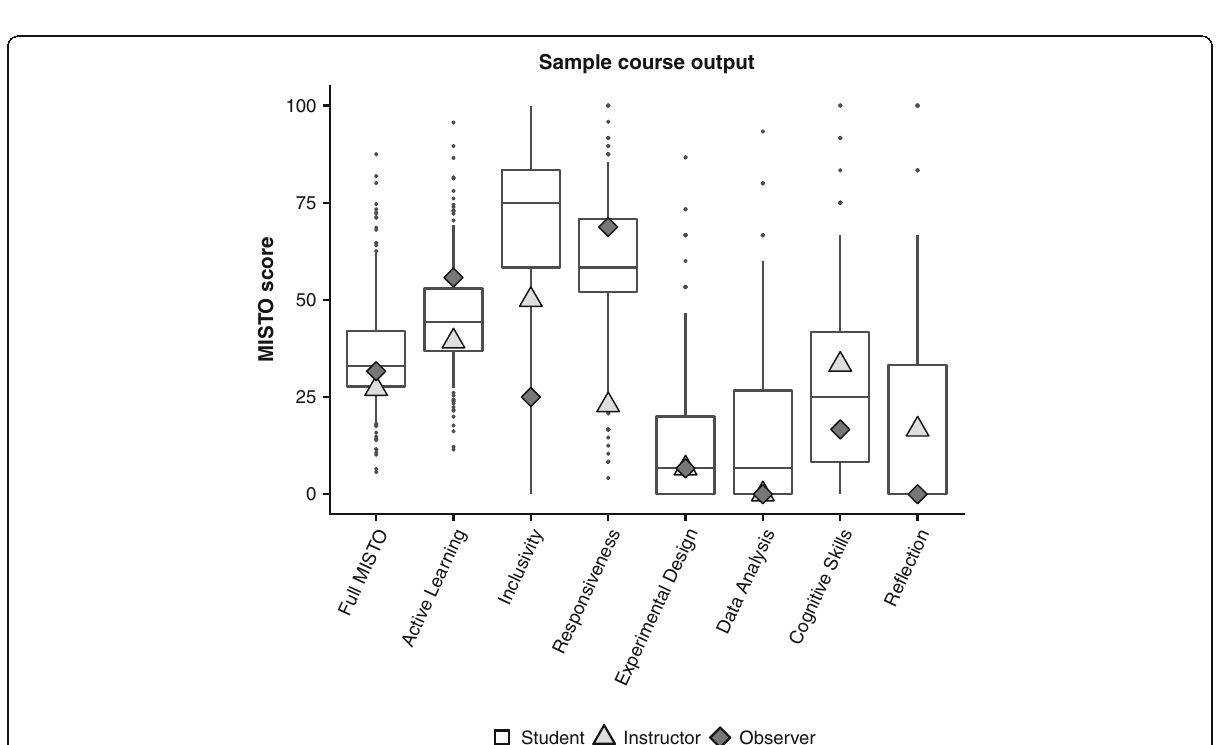
Fig. 6 Sample MISTO course output. Example output of student, instructor, and observer MISTO scores for an example course. Light gray triangles represent the instructor scores, and the dark gray diamonds represent the observer score. Box plots represent student responses; n =310 students. Central bars represent median scores, boxes reflect interquartile range, whiskers reflect the 5th and 95th percentile range, and dots represent data points outside this